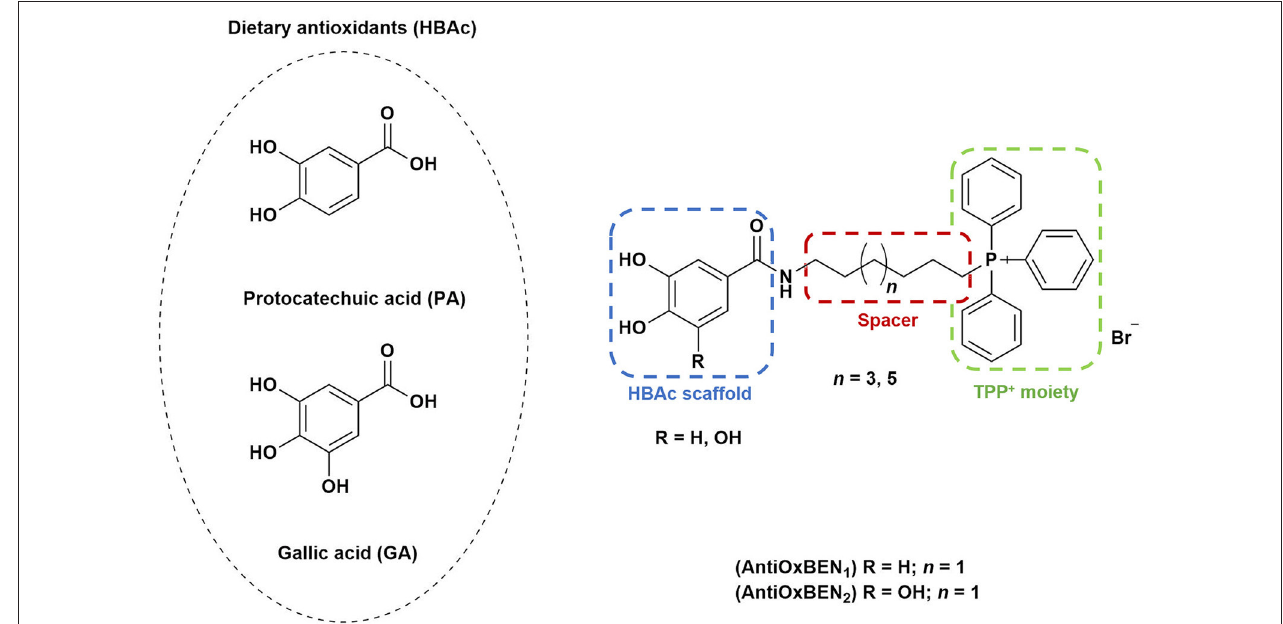
FIGURE 1 | Rational design followed to develop novel dual target agents (ChE inhibitors and mitochondriotropic antioxidants).